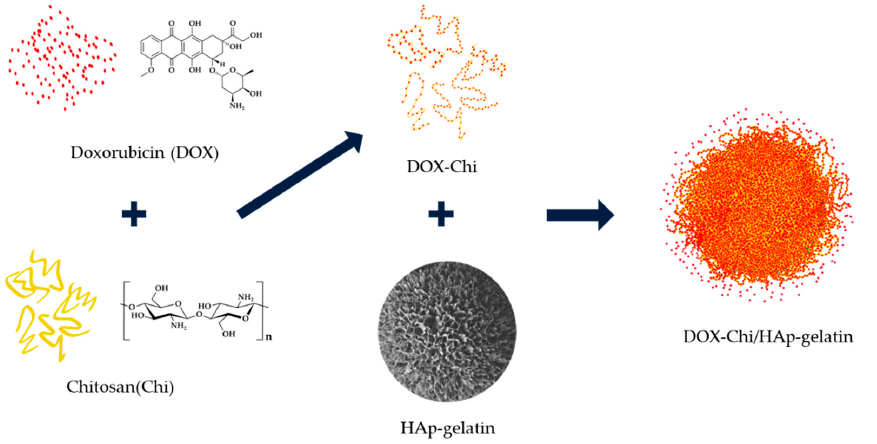
Figure 5 . The chemical structures of DOX and chitosan are drawn and presented by red dot and yellow fiber, respectively. They can form hydrogen bonds to combine with each other due to abundant